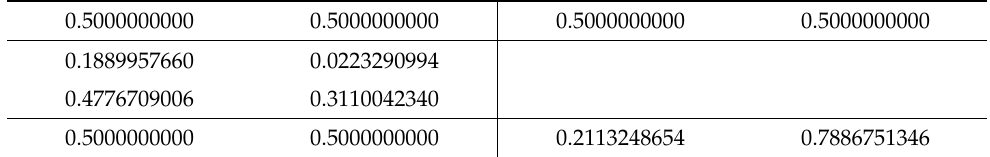
Table A25. eL2|G2 method.